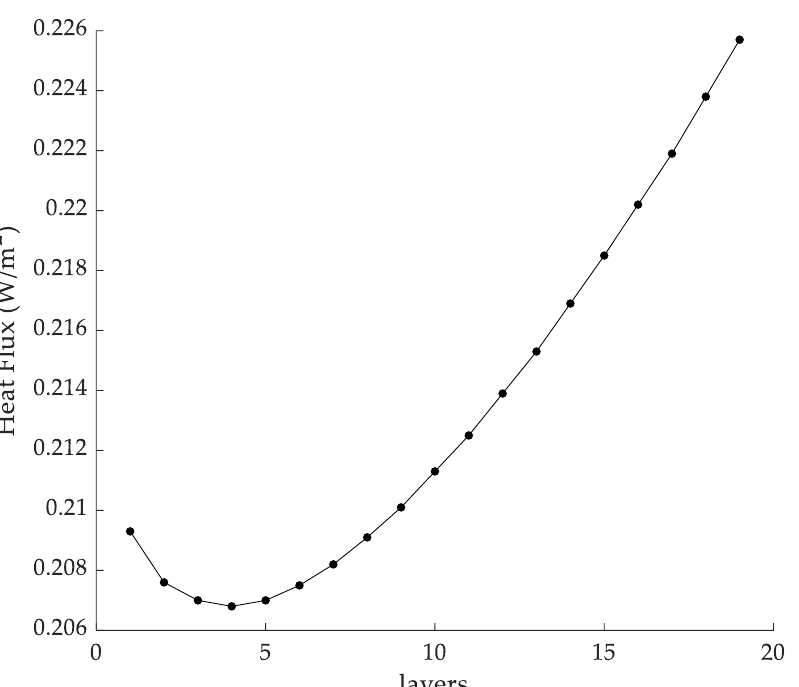
Figure 11. Variation in heat flux with the number of insertion layers in the low-density region.